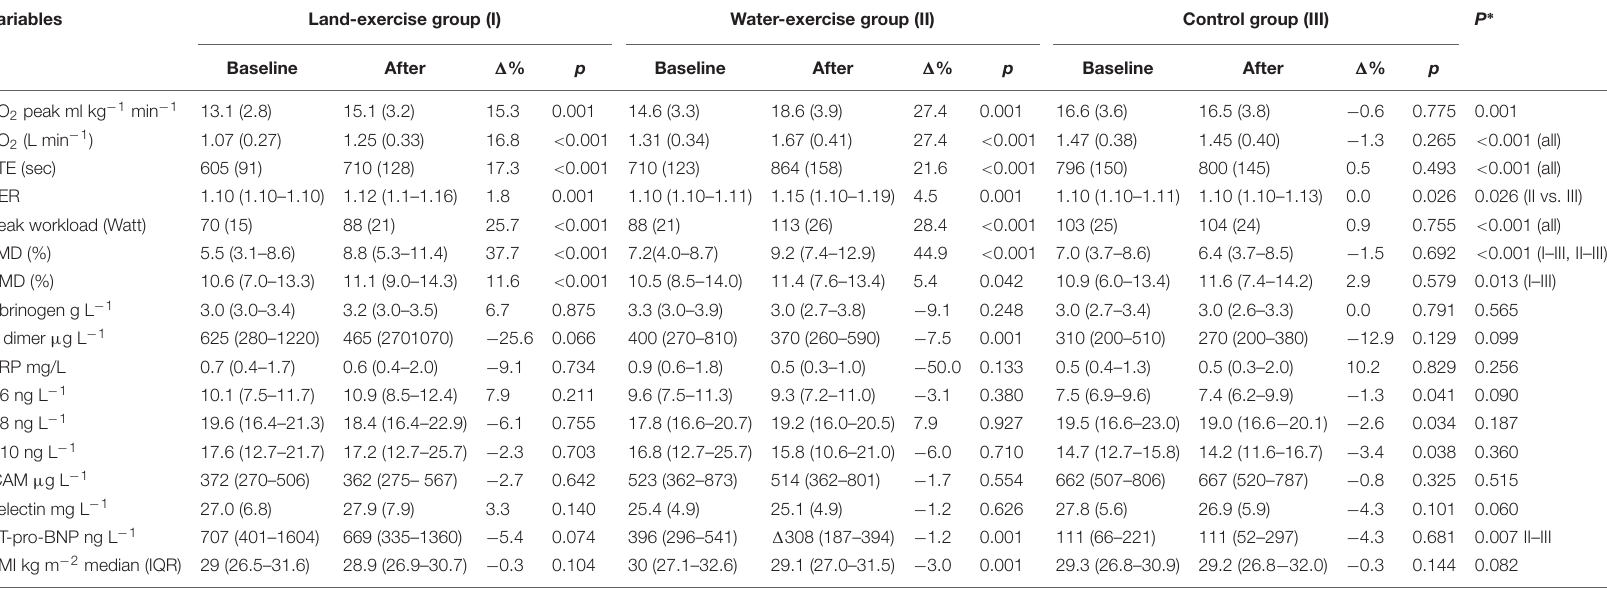
Data are shown as mean and standard deviation (SD) or median and 25th percentile – 75th percentile. TTE, time-to-exhaustion; RER, respiratory exchange ratio; FMD, flow-mediated dilatation; NMD, nitroglycerin- mediated dilatation; CRP, C-reactive protein; IL, interleukin; ICAM, intercellular adhesion molecule; NT-proBNP, N-terminal prohormone B-type natriuretic peptide; BMI, body mass index. p ∗ , p between groups